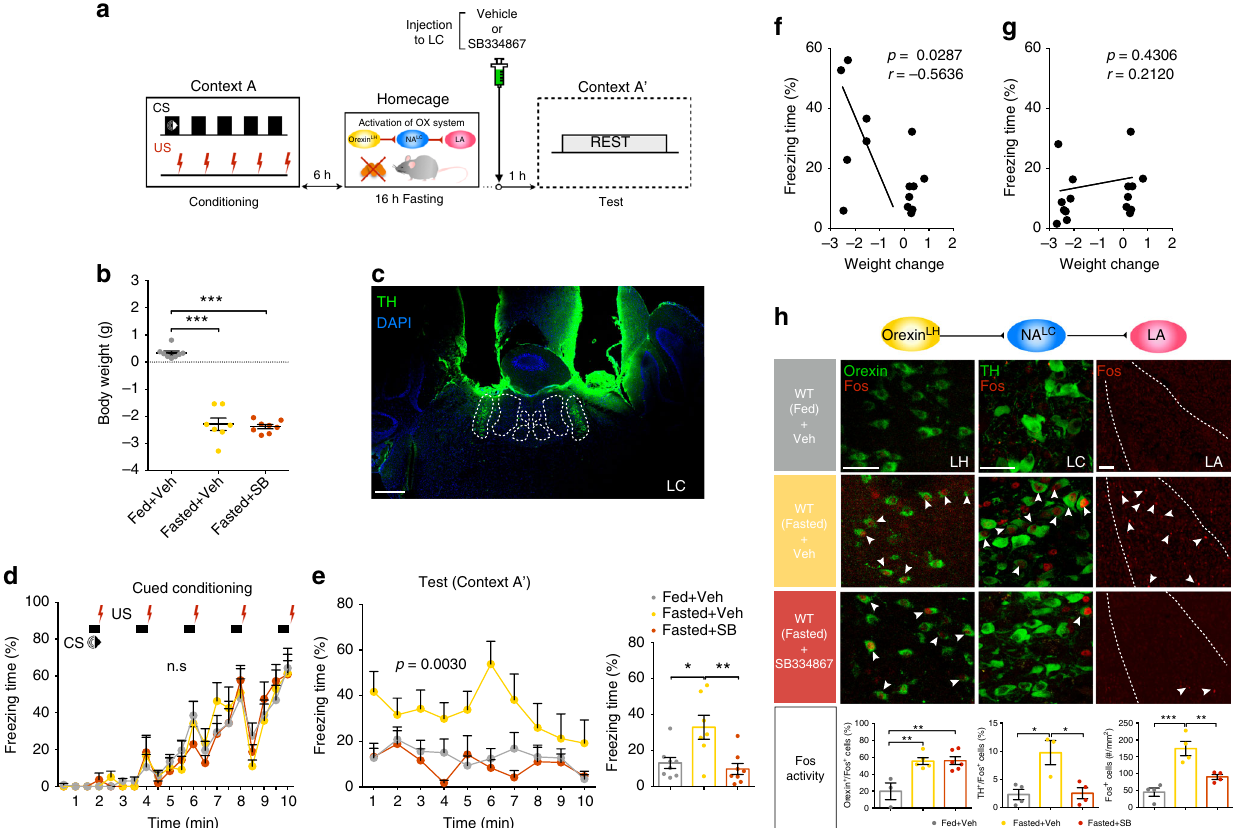
Fig. 7 Physiological activation of orexin LH to NA LC pathway increased freezing behavior. a Experimental procedure. b Mouse ’ s body weight was signi fi cantly decreased after fasting. c Representative image showing the bilateral placement of stainless cannula above the LC. d Gradual increase of freezing was observed during conditioning. e Six hours after cued fear conditioning following fasting for 16 h, mice showed increased freezing response in context A ′ compared to the fed groups, and this response was attenuated by injection of SB334867 in the LC 1 h before the test session. f There were negative correlation between freezing time and weight change of Fed + Veh and Fasted + Veh groups. g There were no correlation between freezing time and weight change of Fed + Veh and Fasted+ SB groups. h Orexin neurons, NA LC neurons, and LA neurons were highly activated by fasting condition, and focal administration of SB334867 into the LC inhibited activation of NA LC and downstream LA neurons. Images show the Fos + /Orexin + cells in orexin neurons (left column, scale bar: 50 μ m), Fos + /TH + cells in NA LC neurons (center column, scale bar: 50 μ m), Fos + cells in the LA region (mm 2 ) (right column, scale bar: 100 μ m) in each group (Fed + Veh, upper; Fasted + Veh,middle; Fasted + SB, bottom, Fig. 7h). Bottom fi gures showed the percentage